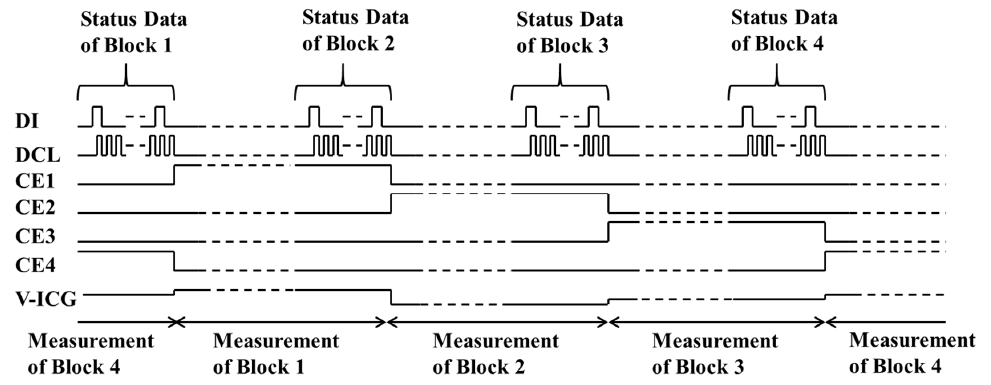
Figure 3. Serial timing chart for the operation of four blocks.